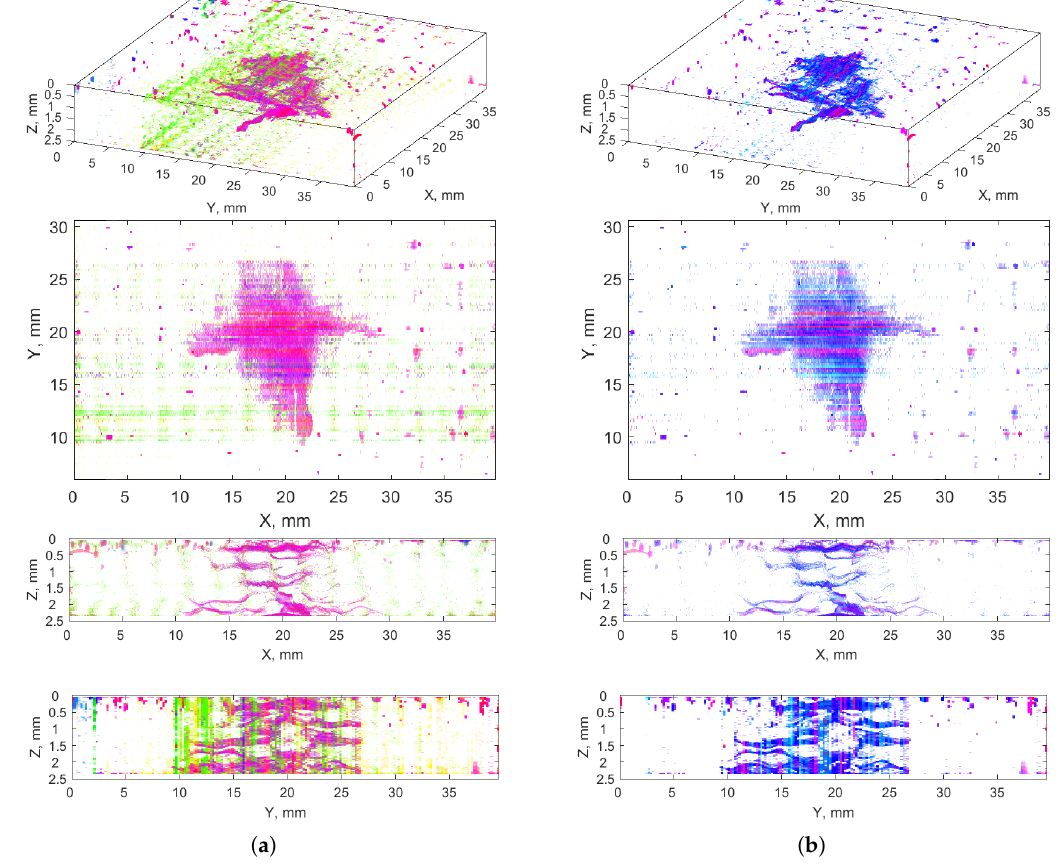
Figure 7. Recognized anomalies: ( a ) all clusters (nos. − 4–12); ( b ) selected clusters with cracks (nos.